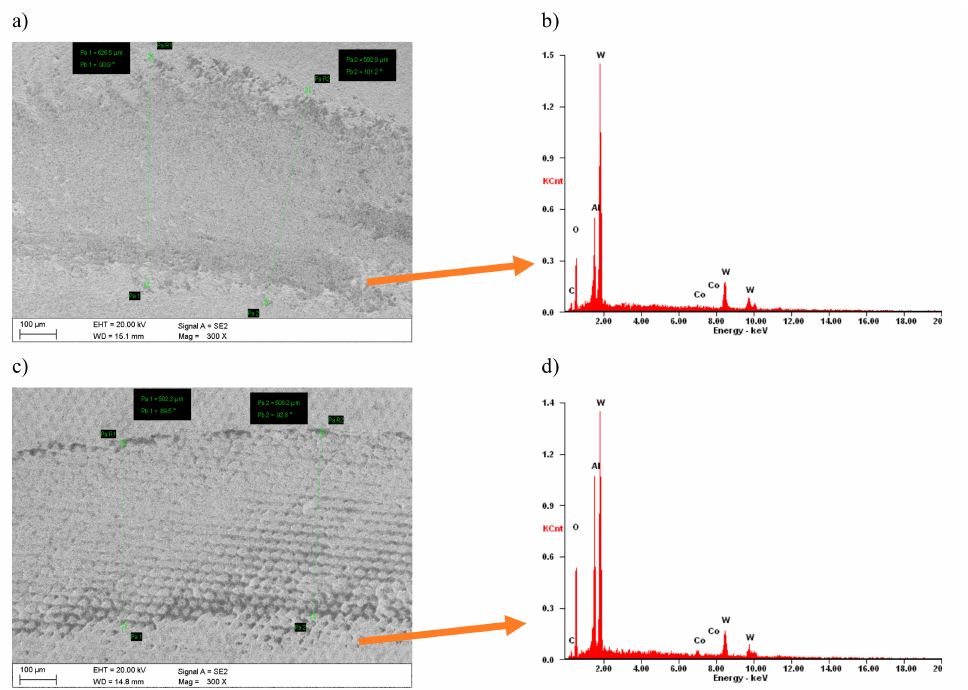
Figure 7. Wear resistance of cemented carbides ( a , b ) before laser texturing, ( c , d ) after laser